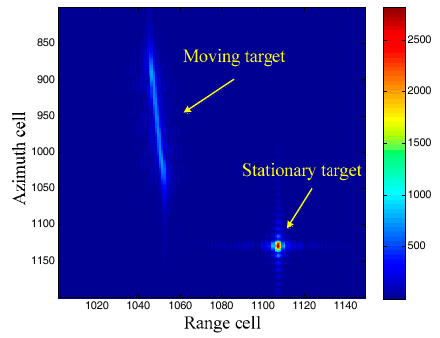
Figure 1. Imaging results by range-Doppler algorithm (RDA).